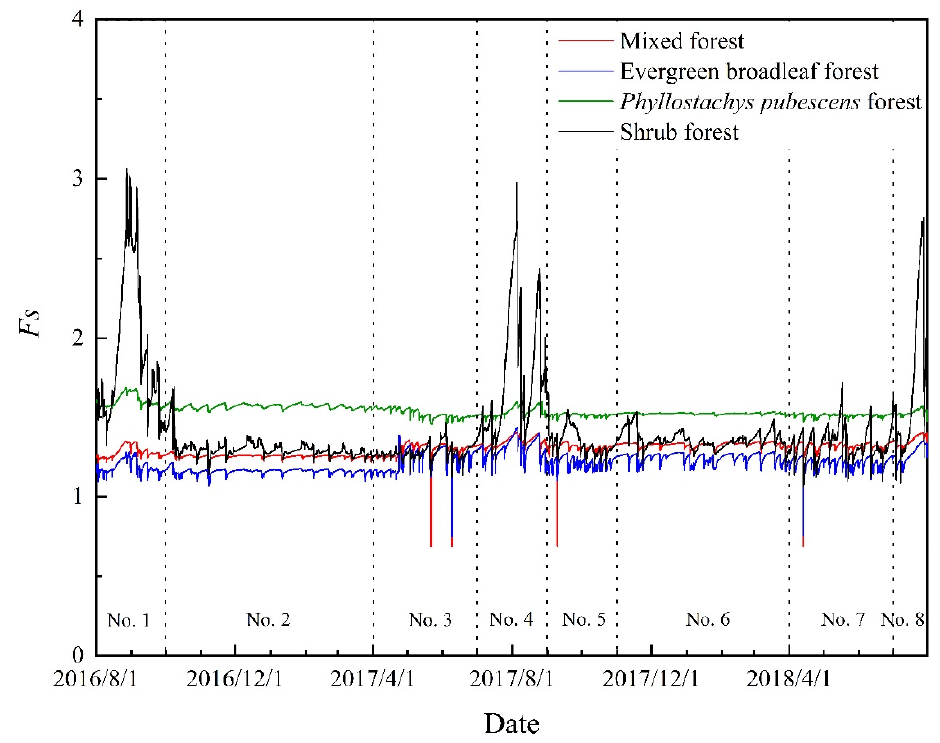
Figure 8. Dynamic changes of hillslope safety factors in different forest lands from August 2016 to July 2018. No. 1–8 is the number of Fs variation in different phases.